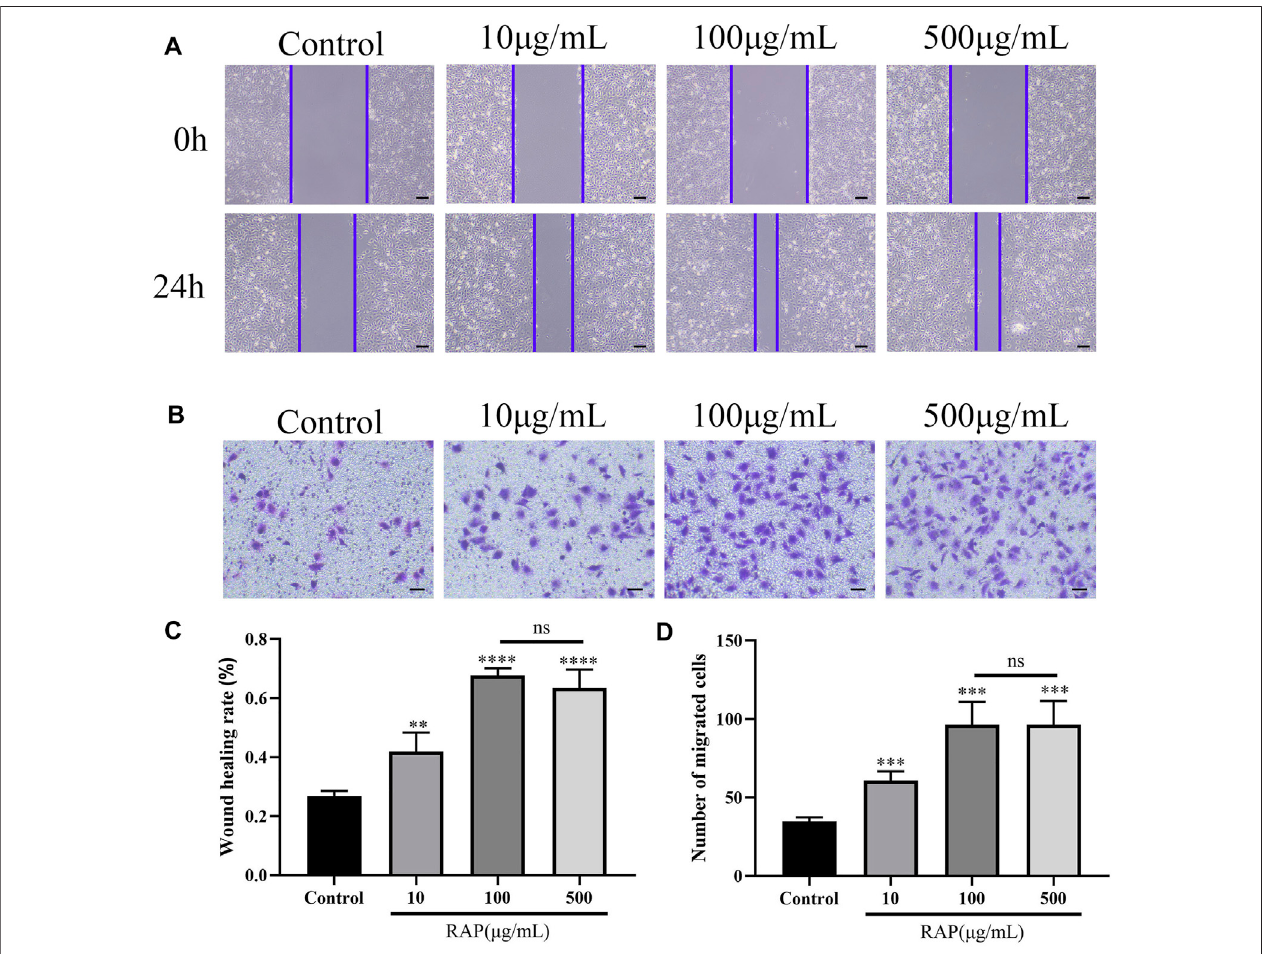
FIGURE1| RAPpromotedEC migration (A) Scratch woundmigrationassay invitro .RepresentativeimagesofmigratingECs treated withdifferentconcentrations of RAP for 24 h (40× ampli fi cation, scale bar = 200 μ m); (B) Transwell chamber migration assay in vitro. Representative images of vertical migration of ECs treated with differentconcentrationsofRAPfor24 h(100×ampli fi cation,scalebar=100 μ m); (C) WoundhealingrateofECstreatedwithdifferentconcentrationsofRAPfor24h; (D) The number of migrating ECs treated with different concentrations of RAP for 24 h. Data are presented as means ± SD. ** p < 0.01, *** p < 0.001, **** p < 0.0001 compared with the control